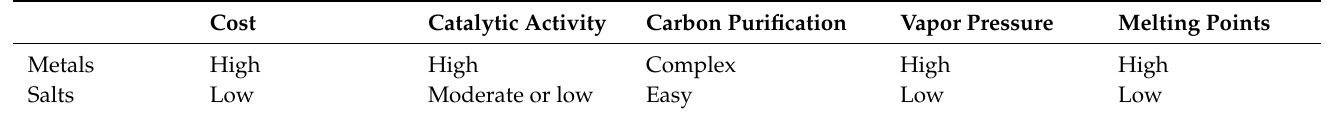
Table 7. Comparison between the features of molten metals and molten salts used in methane